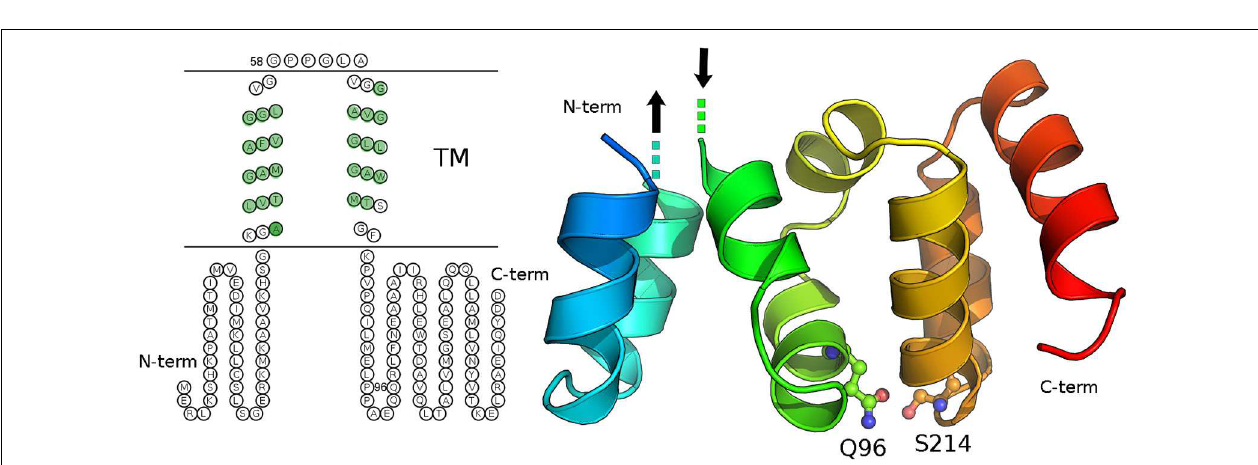
control (left panel). Densitometry of light LC3 chain (LC3II) bands normalized on heavy LC3 chain (LC3I) bands is shown (right panel). Analysis was performed in basal condition or after stimulation with 500 µ M H 2 O 2 for 80min (bars, S.E.M.; n = 4 , * p > 0 . 05 ).